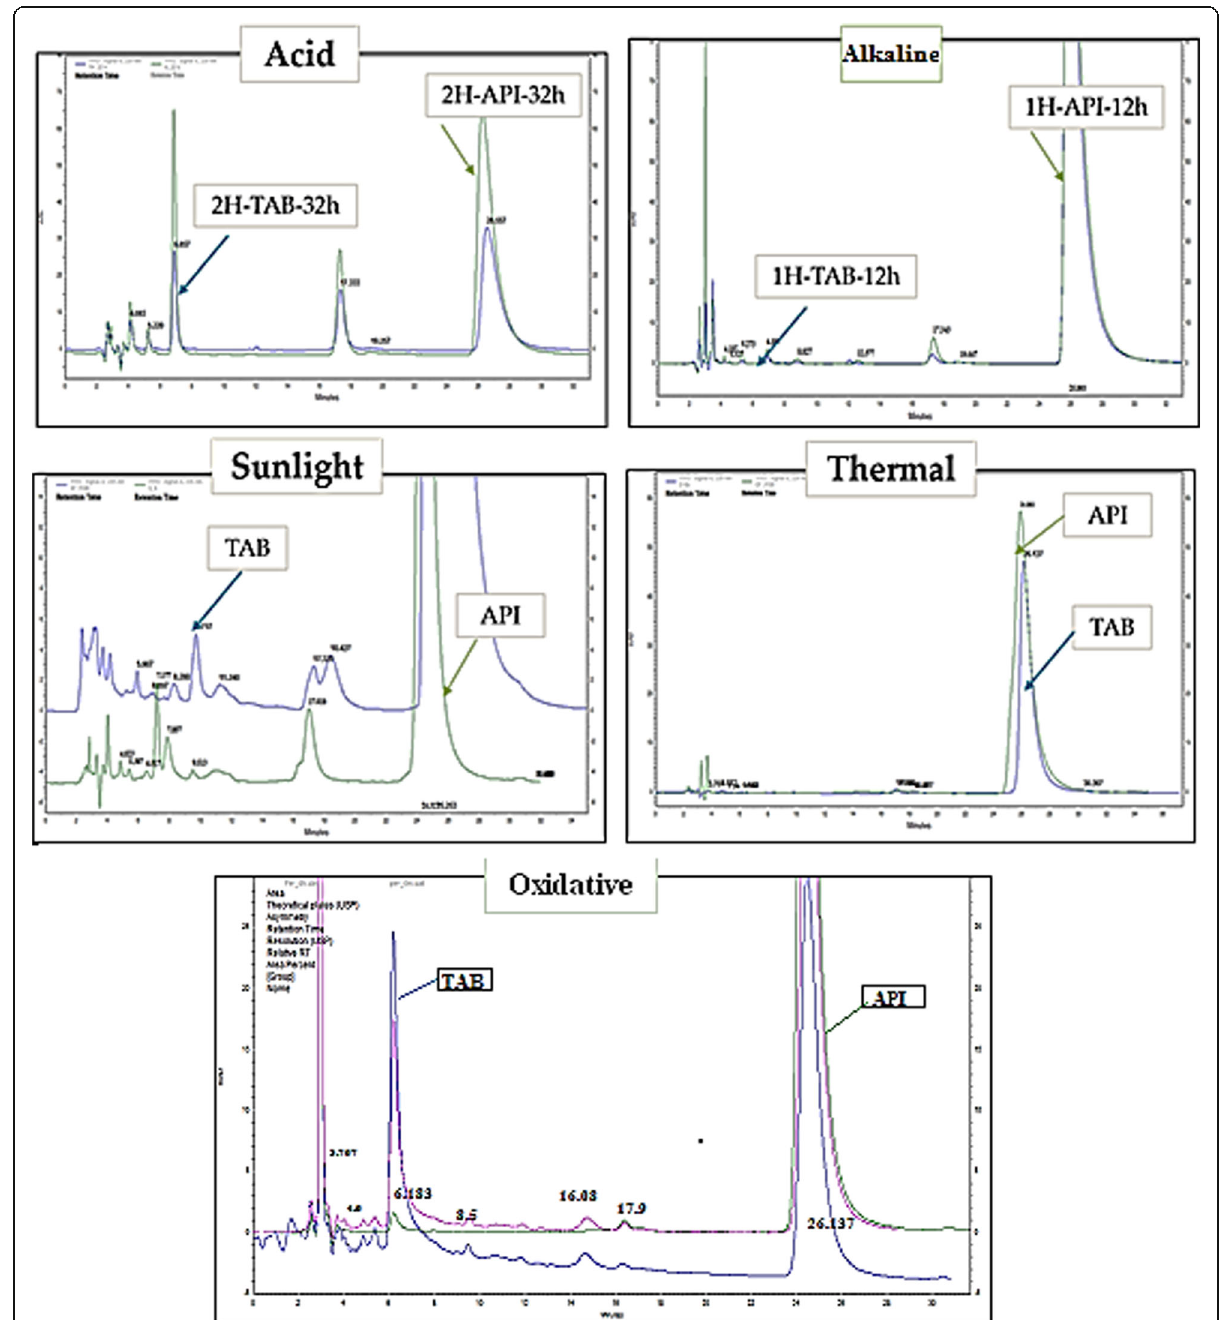
Fig. 7 Overlay chromatogram of AV and its marketed formulation in different stress